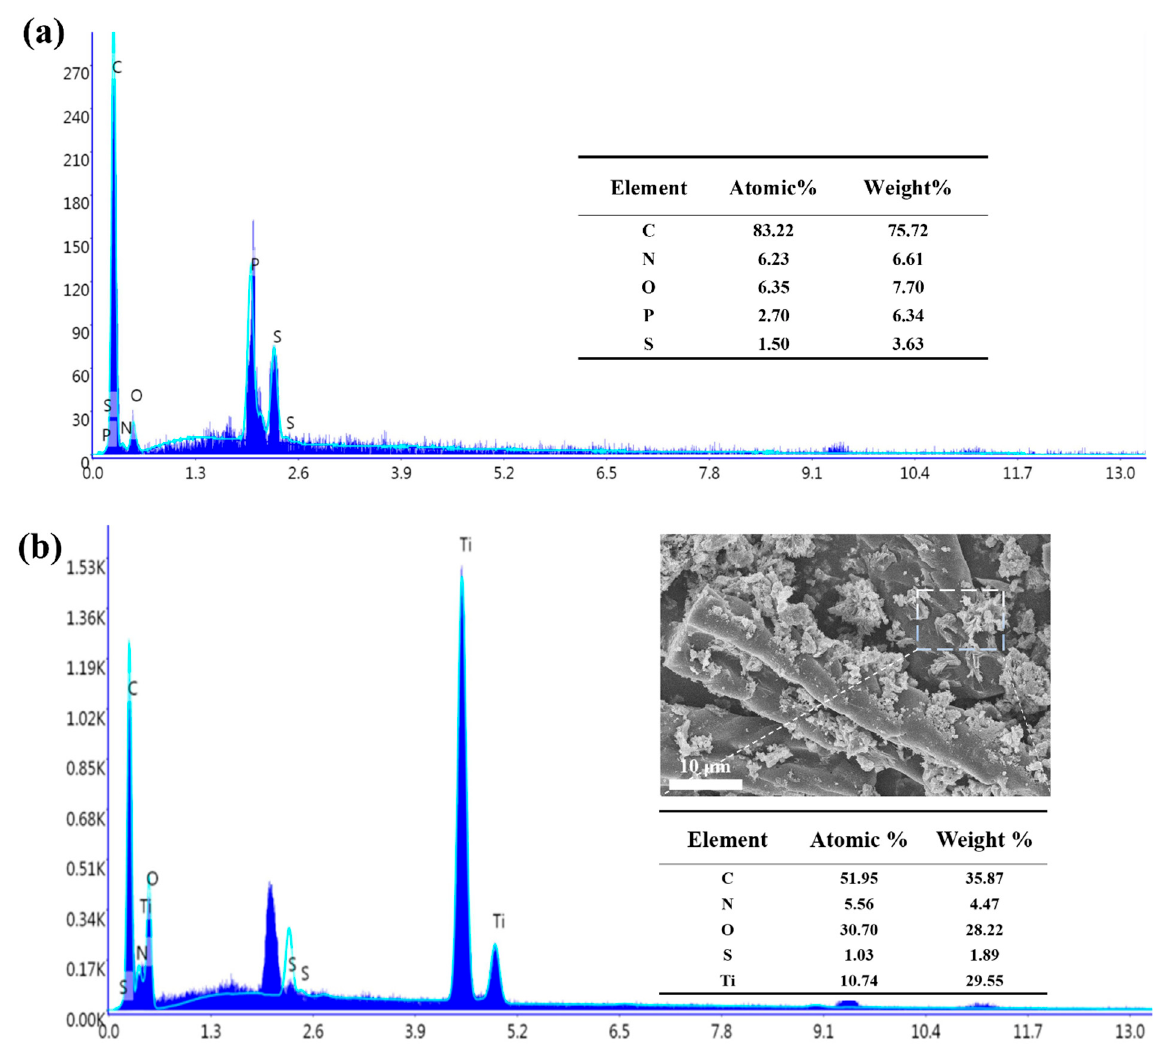
Figure 4. X ‐ ray energy dispersive spectrum of ( a ) CRFs and ( b ) TiO 2 /CRFs (TiO 2 /CRFs =